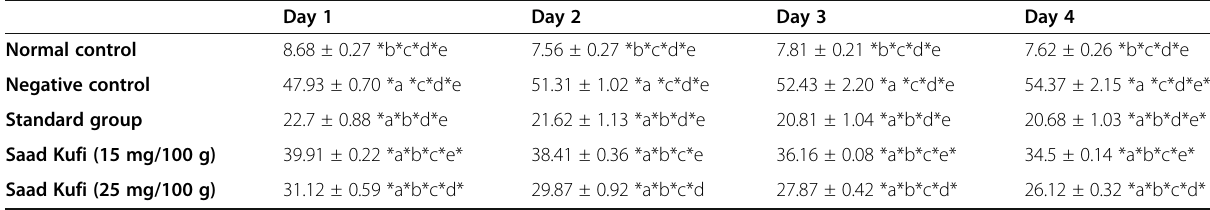
Table 1 Induction of systolic blood